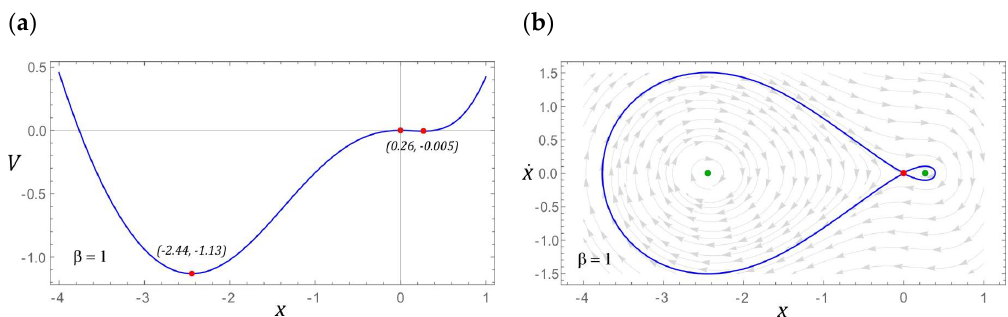
Figure 5. The localization of fixed points is shown as ( a ) potential characteristics, ( b ) phase plane (without damping and excitation) with the corresponding homoclinic orbits and vector field.